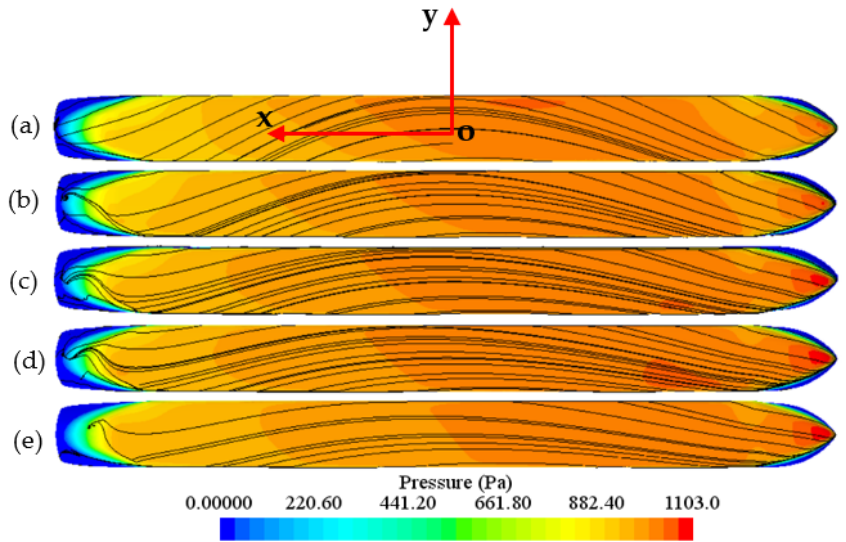
Figure 10. Pressure contours with streamlines of channel radius variation. ( a – e ): Channel radius from 12.52 m to 34.84 m